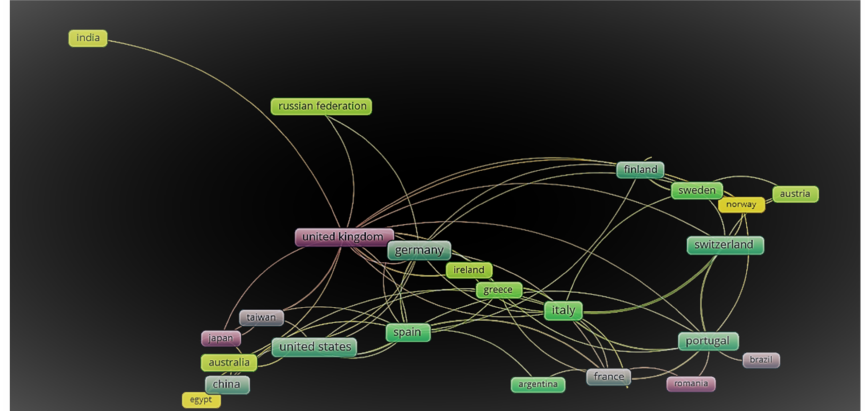
Figure 6. The collaborative work on digital manufacturing